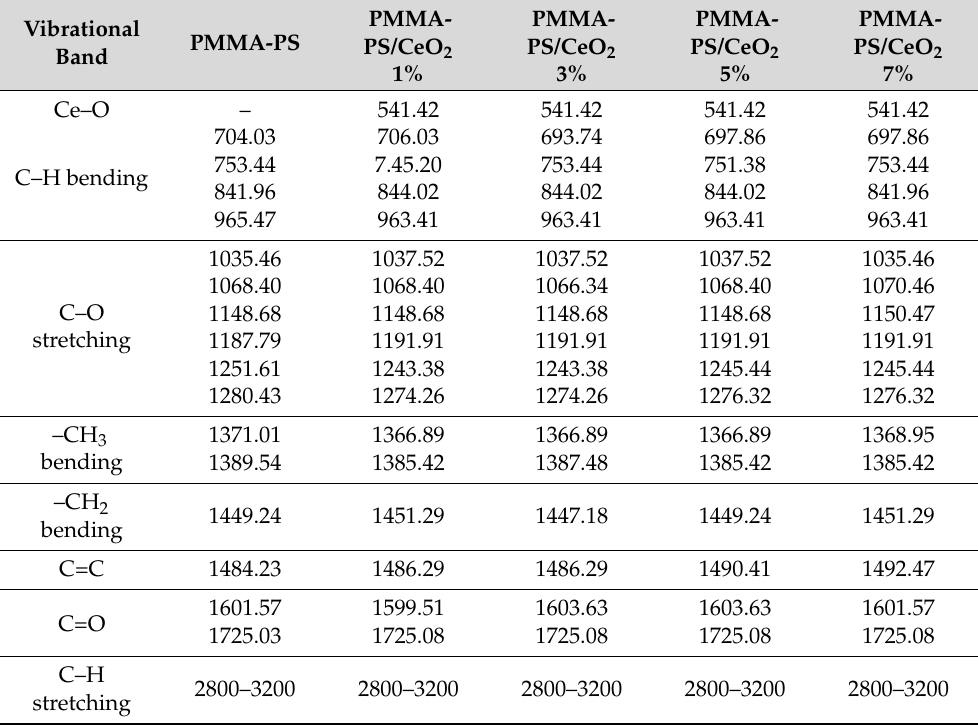
Table 2. The peak positions of all vibrational bands of PMMA-PS, and PMMA-PS doped with CeO 2